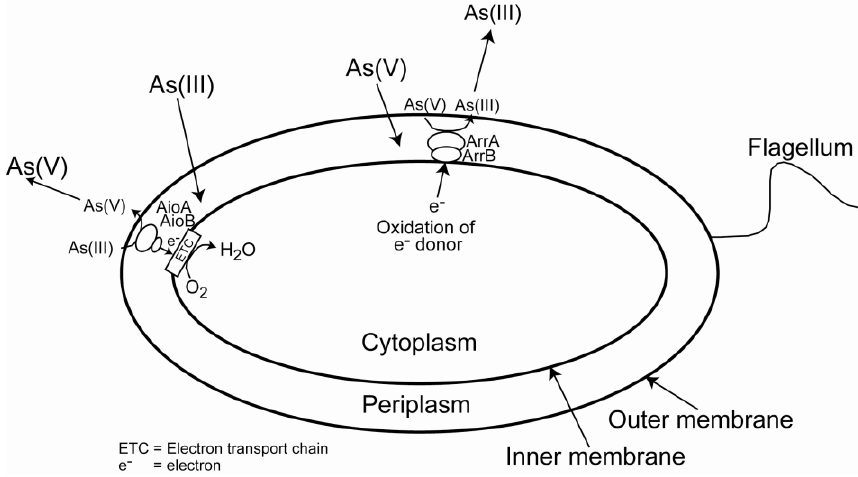
Figure 3. Conceptual diagram of aerobic arsenite oxidase. Arsenite enters the periplams and is oxidized to arsenate by Aio. See text for